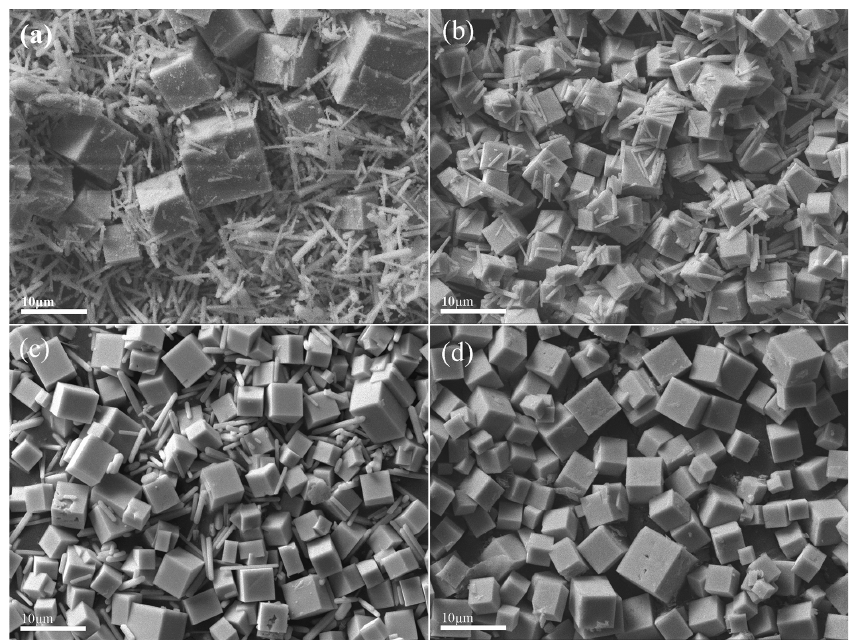
Figure 3. SEM images of products at different hydrothermal synthesis stages: ( a ) 2 h, ( b ) 3 h, ( c ) 6 h, ( d ) 12 h.